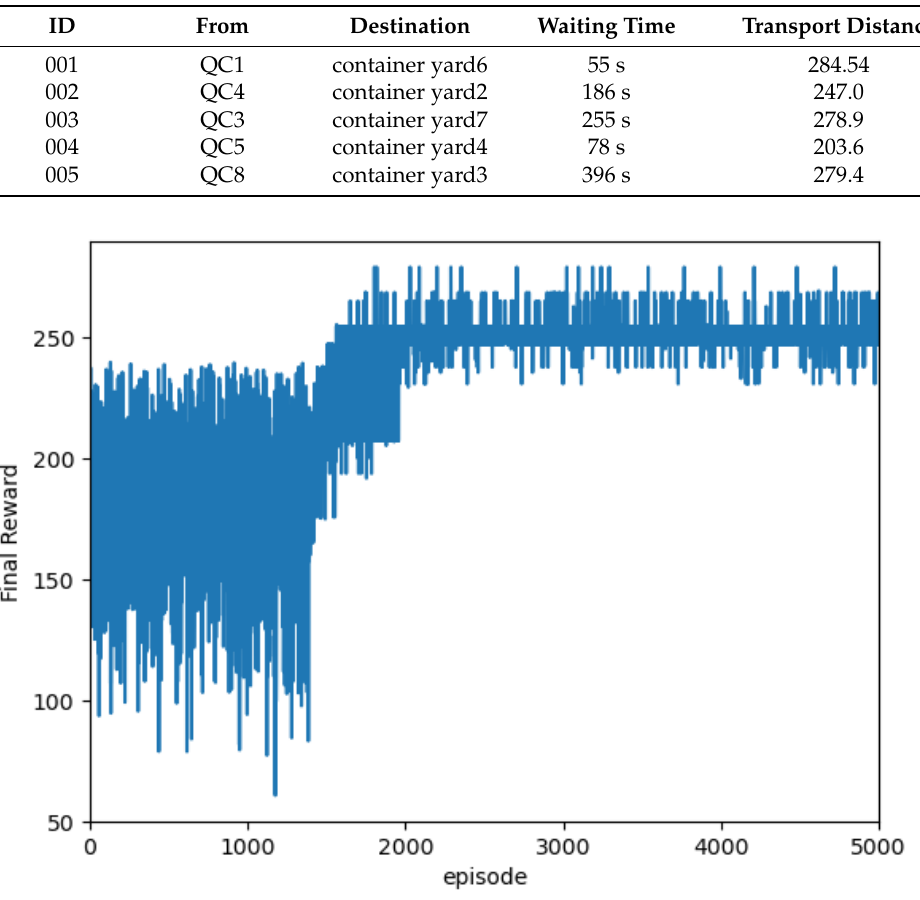
Table 3. Container task information.